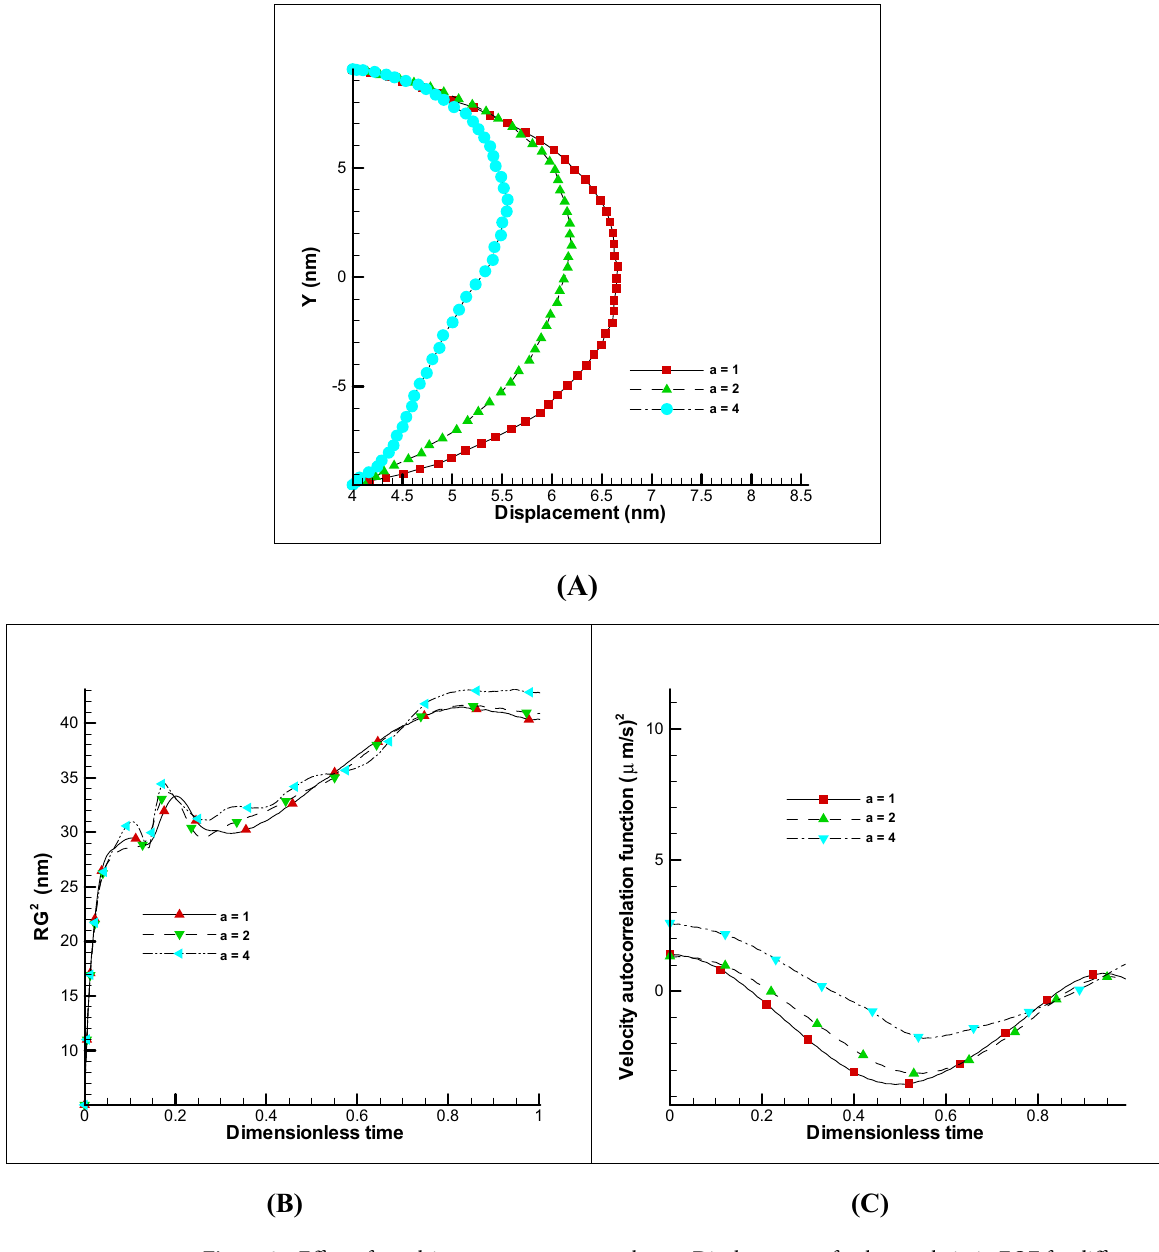
Figure 9. Effect of repulsive parameter on membrane. Displacement of polymer chain in EOF for different repulsive parameter ( A ). Changes of radius of gyration and VACF over dimensionless time (t/t max ) considering different repulsive parameter ( B